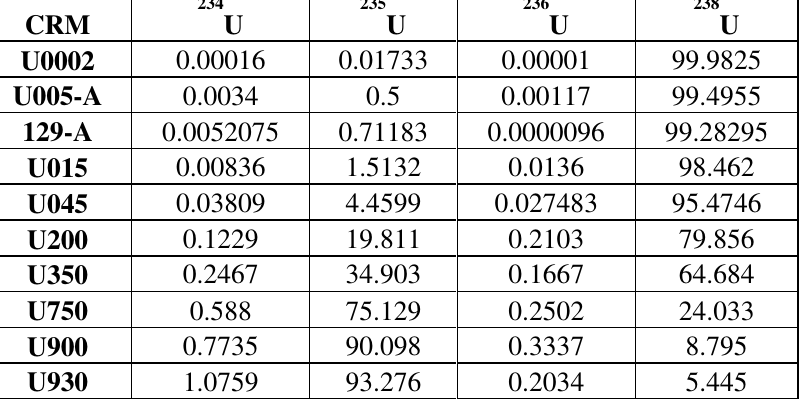
Table 1: Isotopic Concentrations in weight-% for New Brunswich Laboratory Certified Reference Materials [X]. CRM